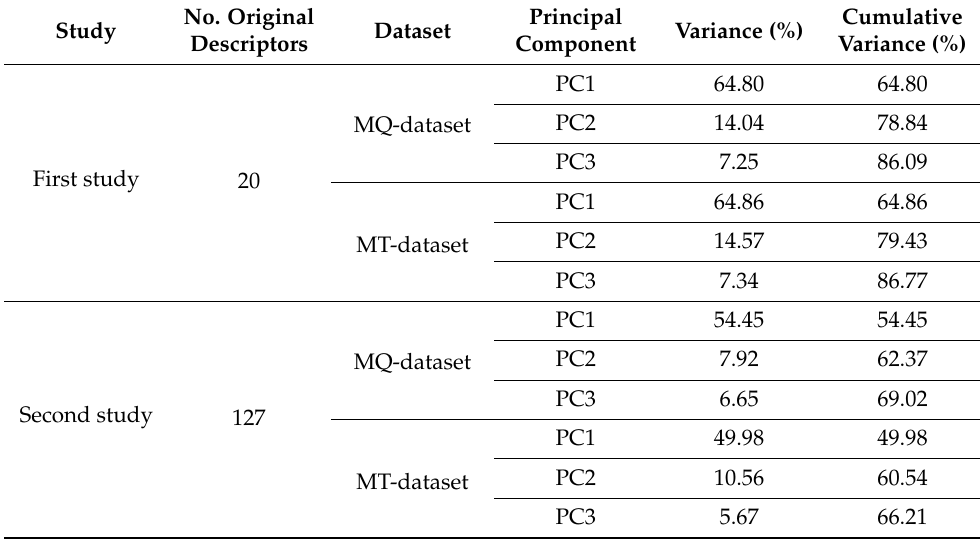
Table 1. Results from the two PCA studies as applied to the MQ-dataset and the MT-dataset. No. Study